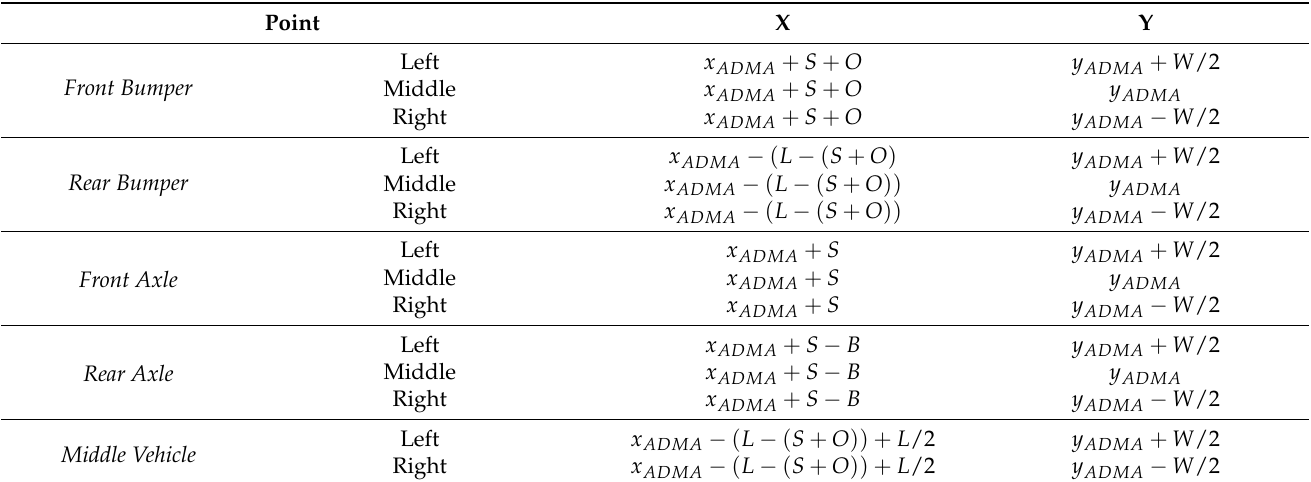
Figure 10. SPT schematization. Table 5. Evaluation of vehicle schematization